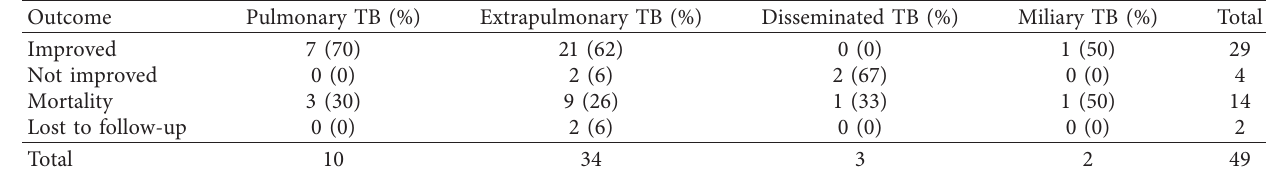
Table 7: Outcomes of TB patients at two months of starting ATT as per different types of